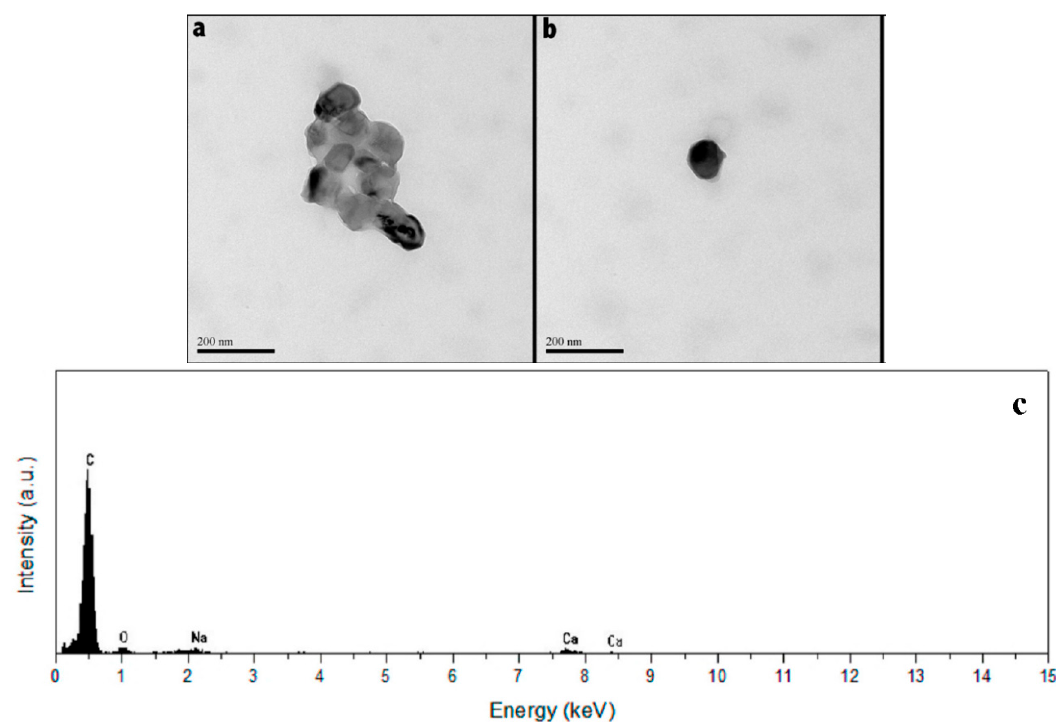
Figure 2. Transmission electron microscope (TEM) of nano-sized PEI/SA hydrogel microcapsules ( a ) agglomerated hydrogel microcapsules; ( b ) single microcapsule; and ( c ) energy dispersive spectrometer (EDS) image of PEI/SA hydrogel microcapsules.